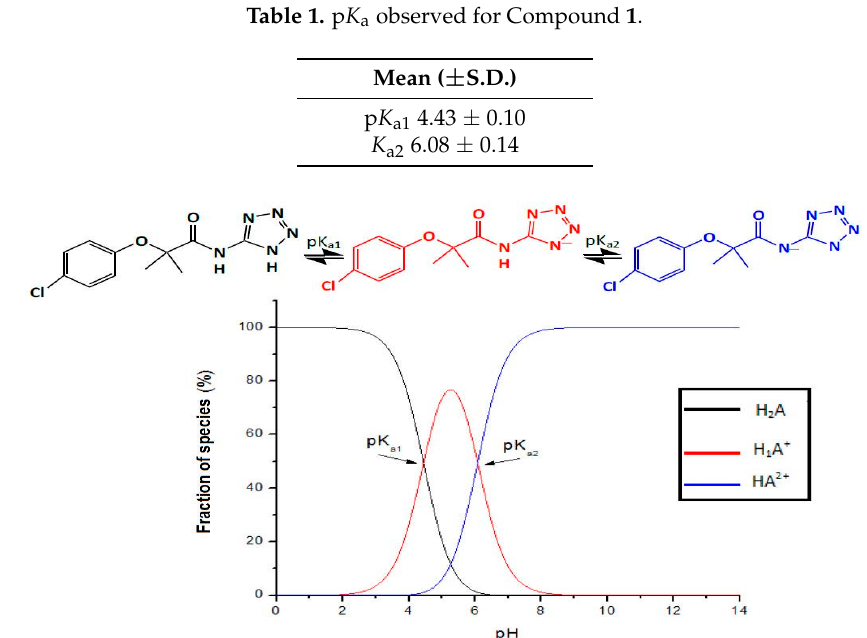
Figure 4. Dissociation equilibrium and speciation diagram for Compound 1 .